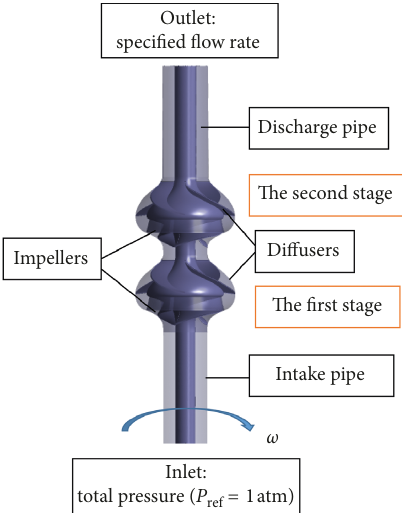
Figure 3: Generic representation of the simulation